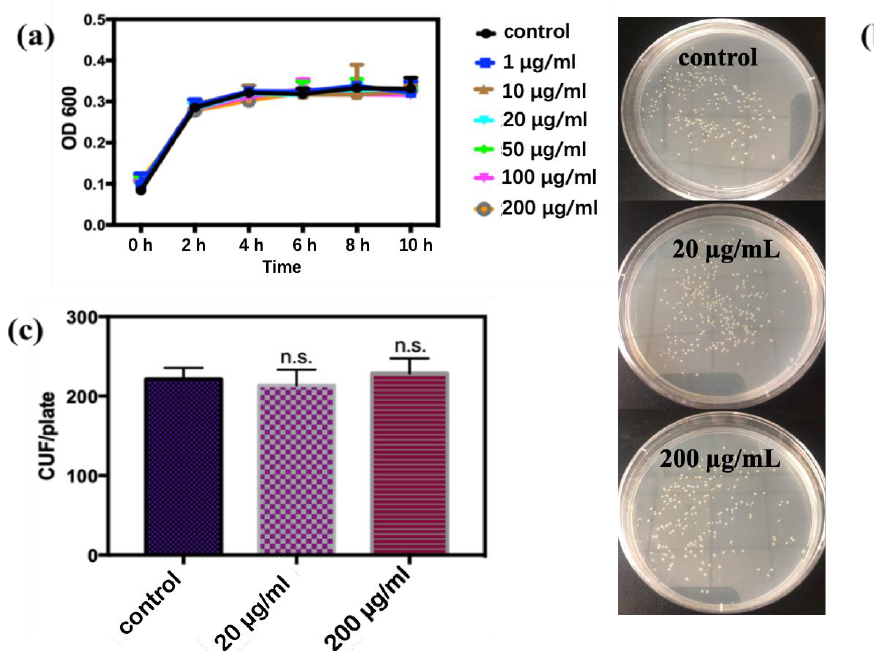
Figure 2. ( a ) Growth curve of E. coli in different concentrations of CQDs; ( b , c ) bacteriostatic test results and CFU count of exposure to different concentrations of CQDs (n.s. p > 0.05).